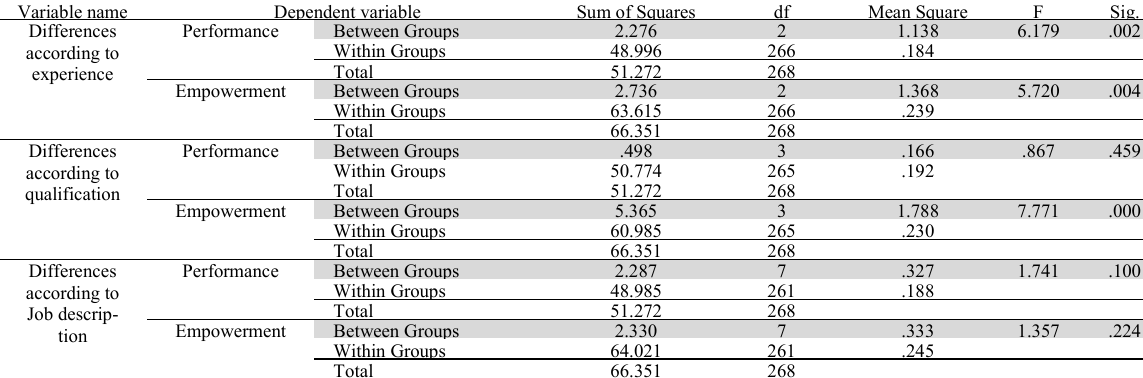
The results of ANOVA